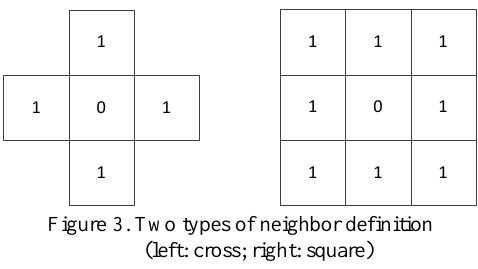
Figure 3. Two types of neighbor definition (left: cross; right: